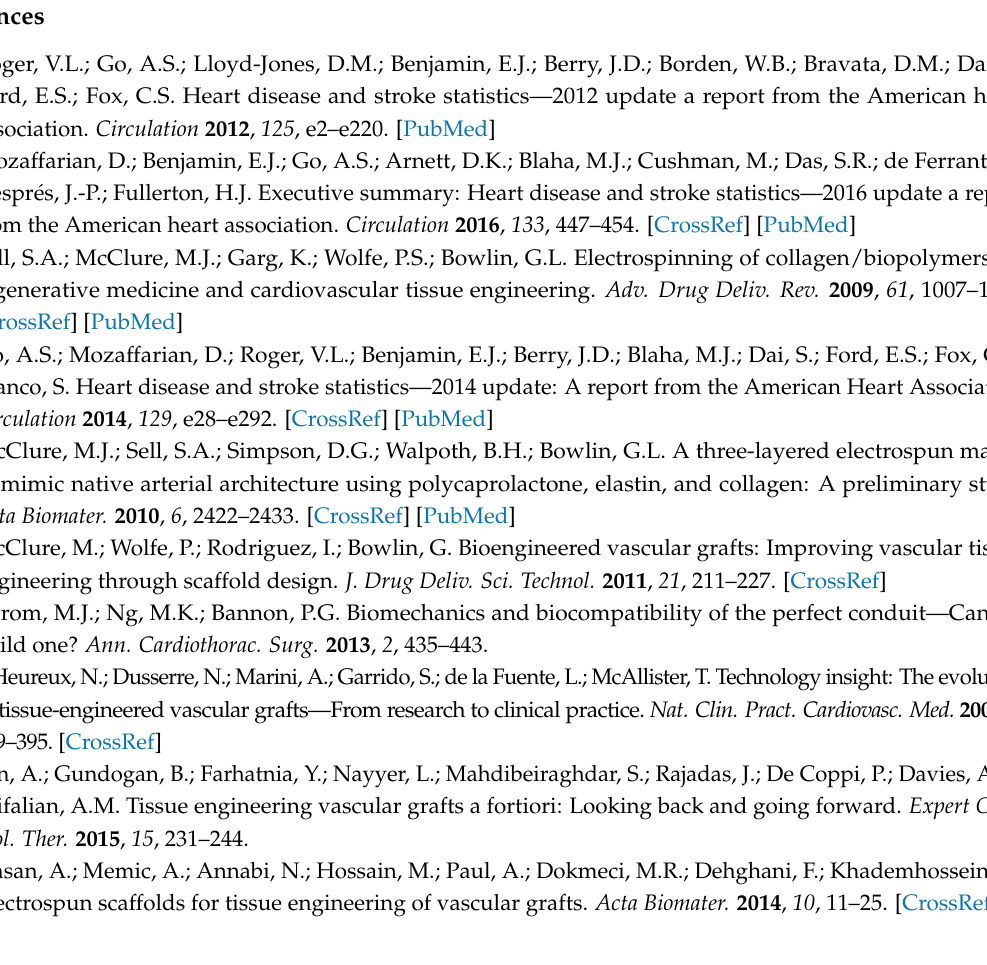
University of Pittsburgh. All Cypher AFM images and data were collected on the W.M. Keck Center for Surface and Interface Imaging at the University of Arizona supported by NSF